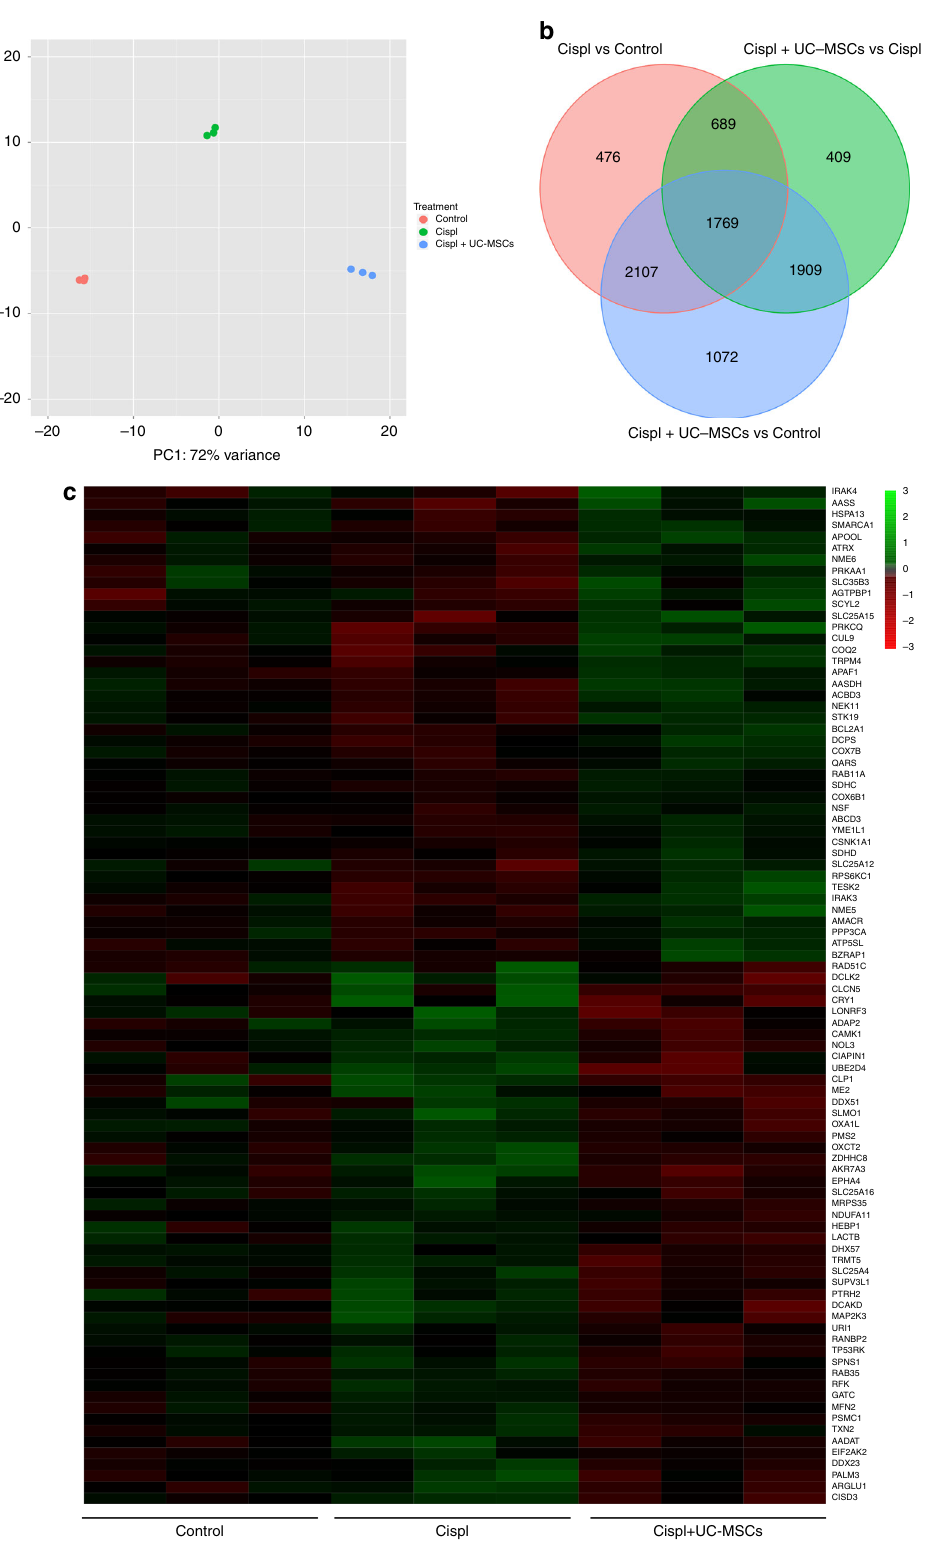
Fig. 2 Human UC-MSCs induce a global transcriptional reprogramming in cisplatin-damaged RPTECs. a Principal component analysis (PCA) on rlog transformed read counts, in which the three RPTEC experimental groups (Control, Cispl, and Cispl+ UC-MSCs) were separated along the axis of major variation (PC1, 72% of variance). b Overlapping of the differentially expressed genes (DEGs) in the three comparisons: Cispl + UC-MSCs vs Cispl, Cispl vs Control, and Cispl + UC-MSCs vs Control. c Clustering of genes related to mitochondrial energy homeostasis among the 409 uniquely DEGs in Cispl + UC-MSCs vs